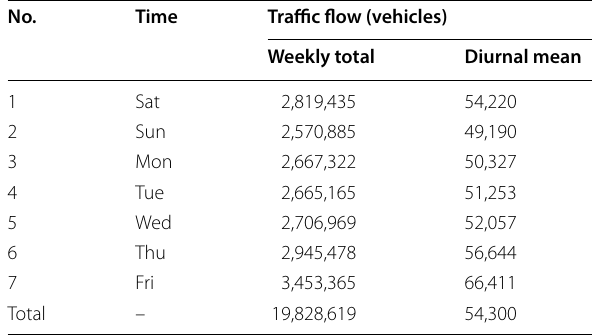
Table 3 Weekly distribution of traffic flow in 2018, after the total hour-by-hour detector of total vehicles in the study area